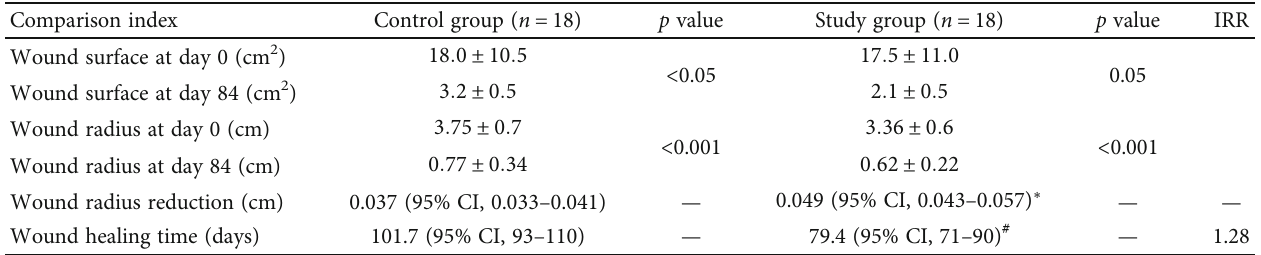
Table 4: Wound parameters and healing